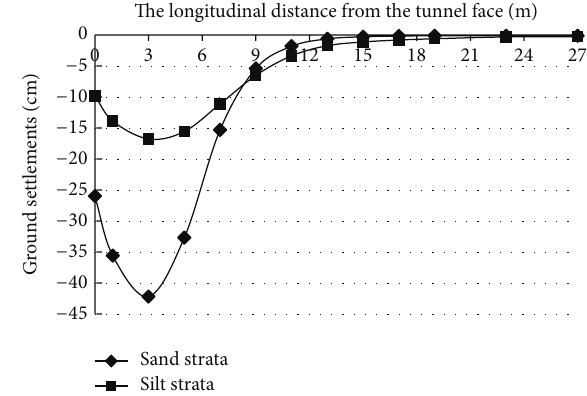
Figure 10: The longitudinal ground settlements ahead of tunnel face after collapse failure of the tunnel face.